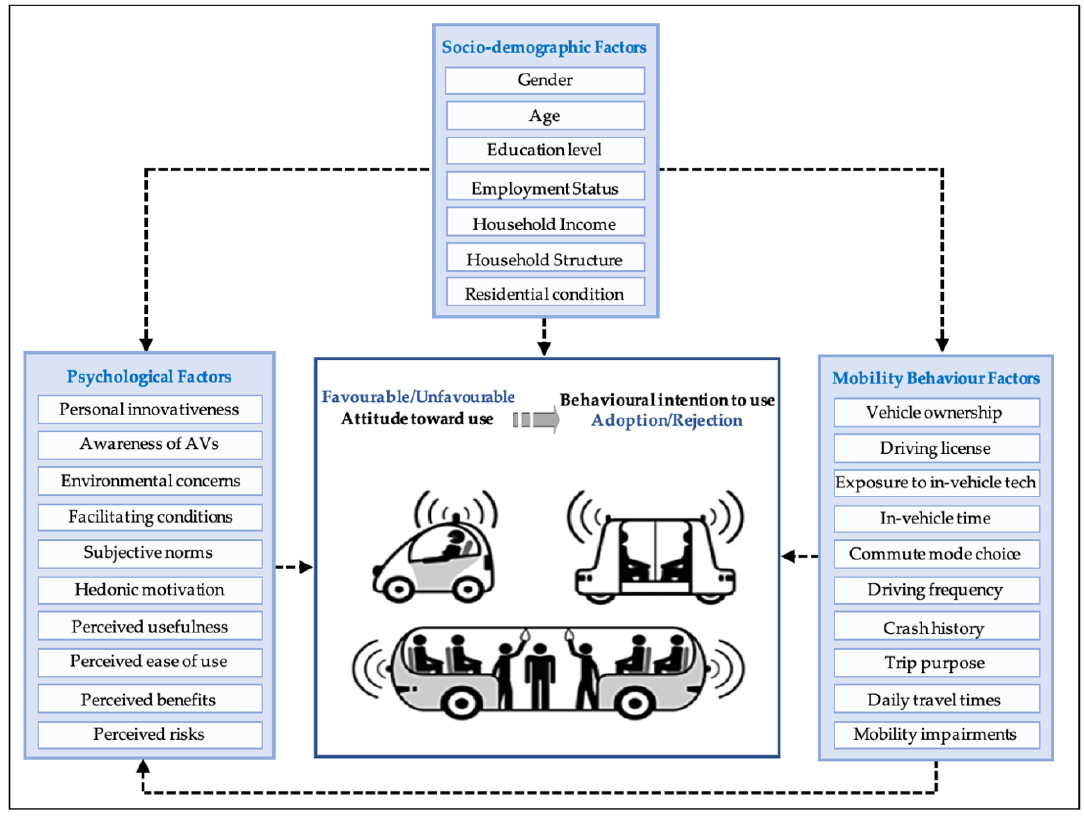
Figure 2. Conceptual framework of individual determinants of AV public acceptance and intention to use (Source: Authors).